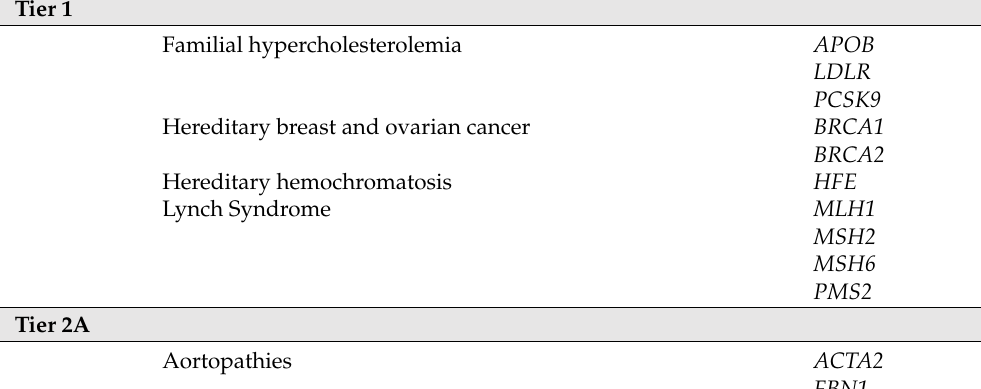
Table A1. Genes selected for return to patients by our return of results committee divided by tier. Tier